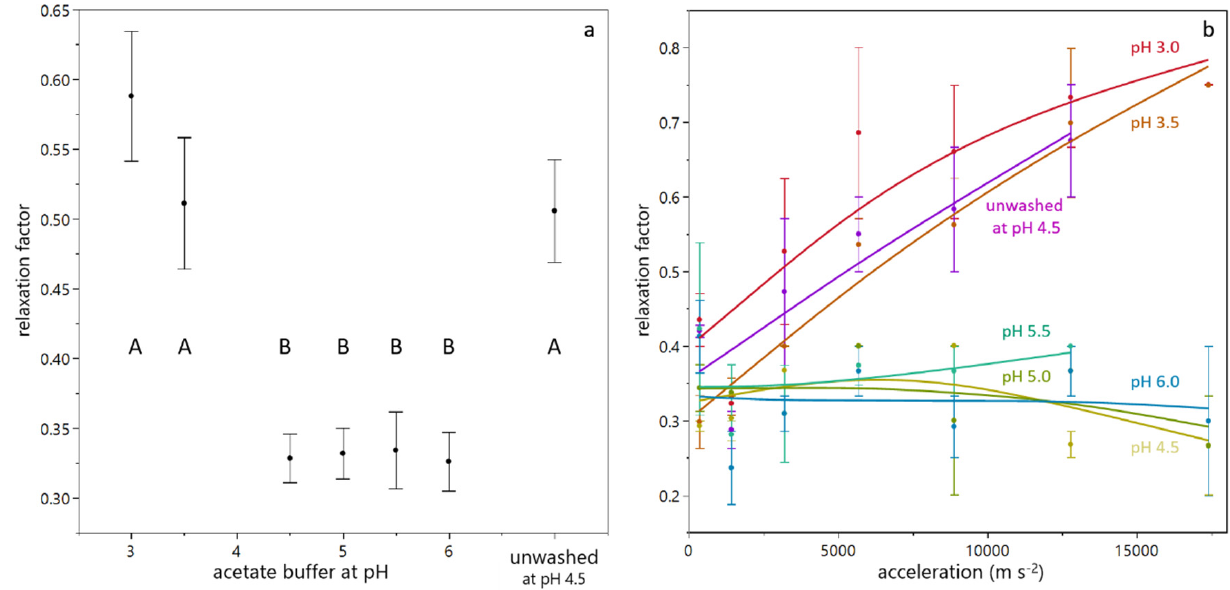
Figure 5. Relaxation behavior during analytical centrifugation of yeast suspensions. The mean relaxation factor depends on the buffer pH ( a ). The error bars indicate the standard error over all values from different centrifugal acceleration and a duplicate measurement. The connecting letters are obtained from a student’s t-test with a 95% confidence interval. For sediments in the connecting letter group (A), the relaxation factor depends on the centrifugal acceleration, as shown in ( b ).